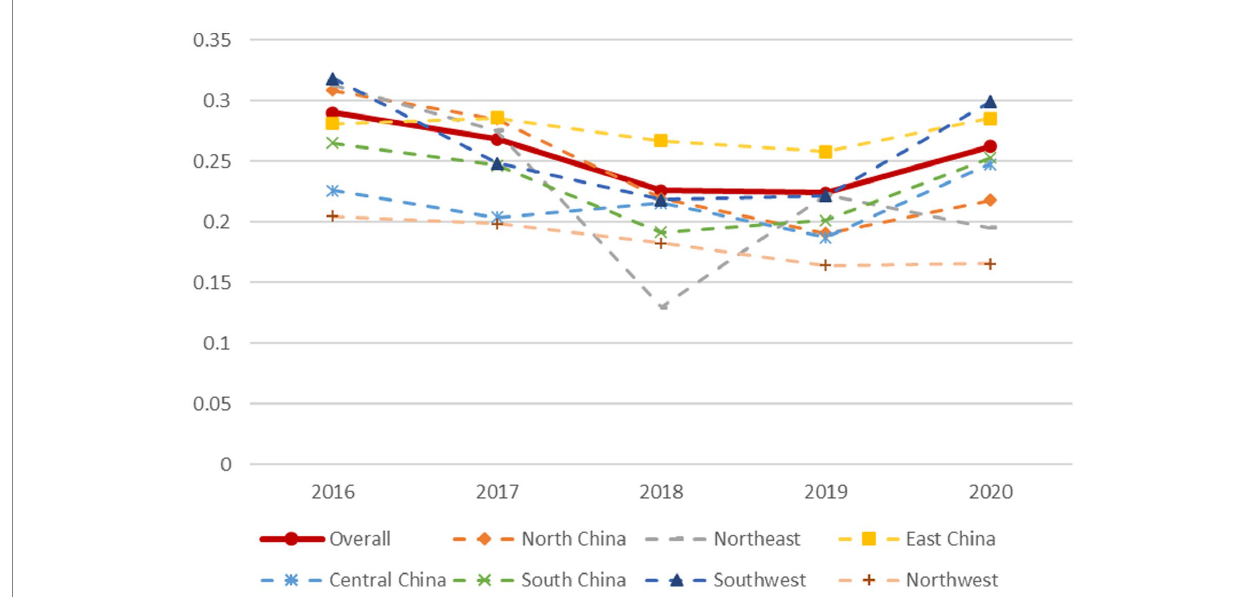
FIGURE 4 Changes in the σ value of innovation efficiency of listed companies in the health industry in various regions.